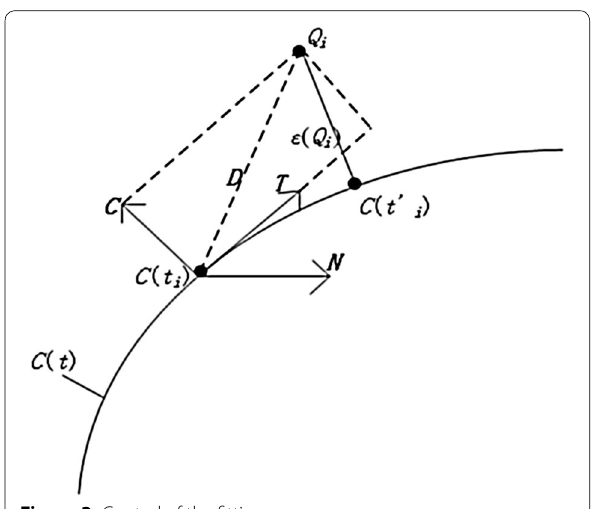
Figure 3 Control of the fitting